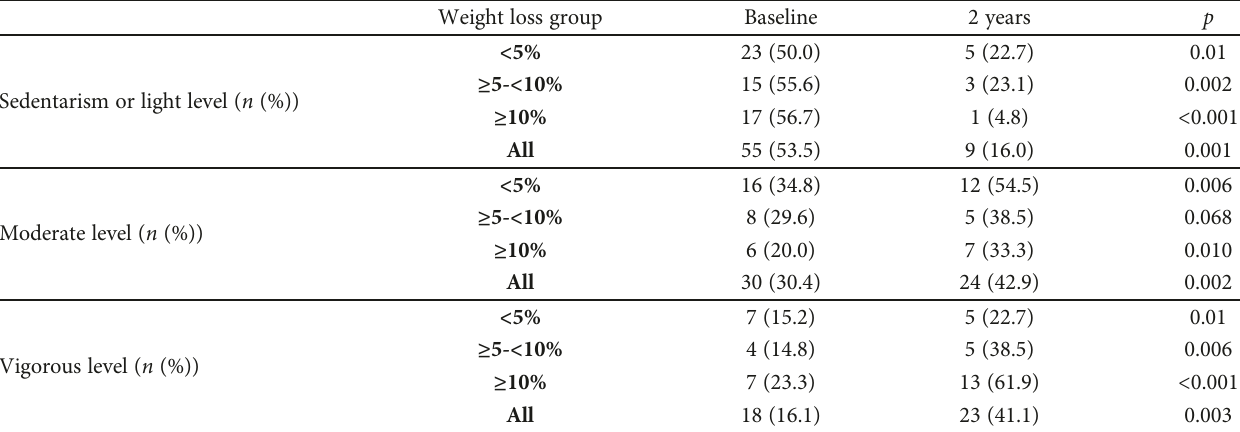
Table 3: Physical activity levels at baseline ( n = 115 MHO participants) vs. after 2 years ( n = 67 MHO participants) of lifestyle modi fi cation, according to percentage of weight loss. Weight loss group Baseline 2 years p Sedentarism or light level ( n